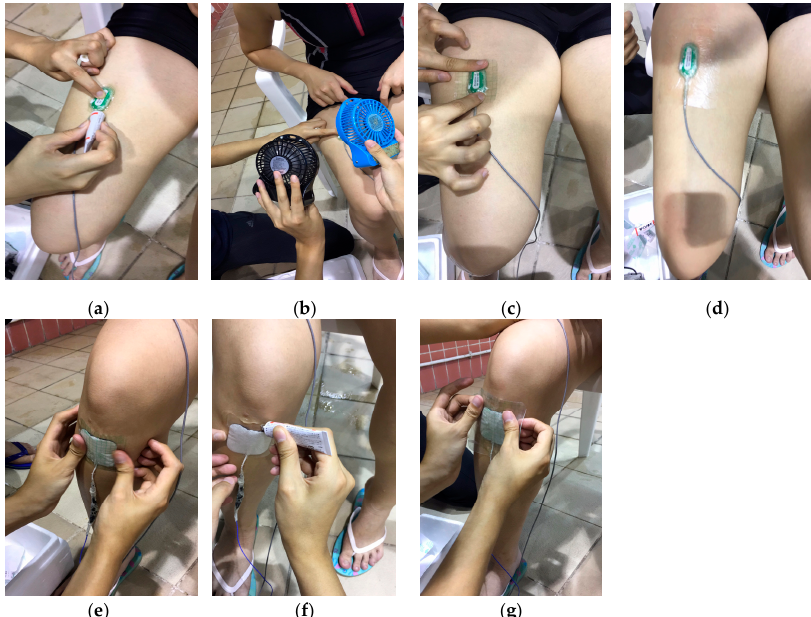
Figure 2. (a) Application of the liquid bandage around the electrode. (b) Dry up process of liquid bandage. (c) Application of the first layer of tegaderm (55 mm x 60 mm) on electrode. (d) Application of the second layer of tegaderm after application of liquid bandage along the edges of the first layer of tegaderm. (e) Application of the first layer of tegaderm (65 mm x 80 mm) on ground electrode. (f) Application of liquid bandage along the edges of tegaderm on ground electrode. (g) Application of the second layer of tegaderm (85 mm × 90 mm) on ground